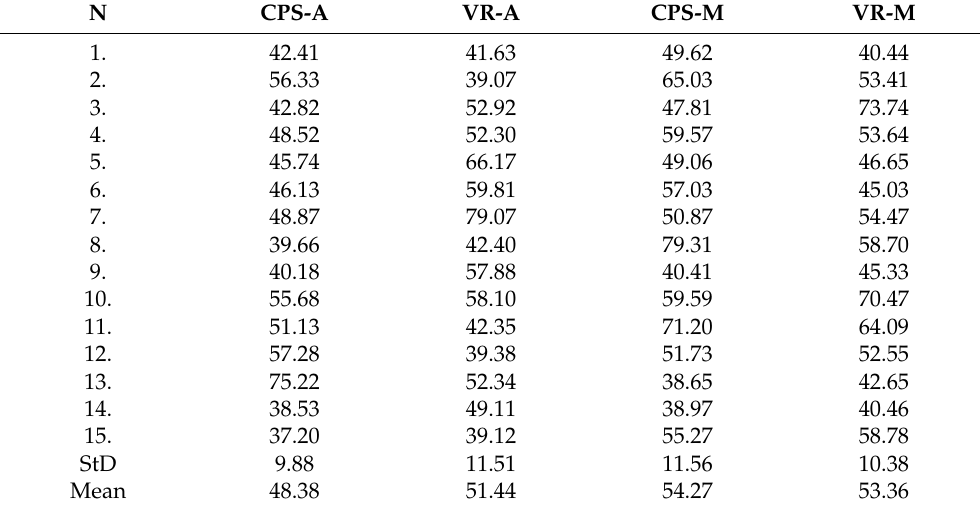
Table 7. Computer problem solving attention (CPS-A), computer problem solving